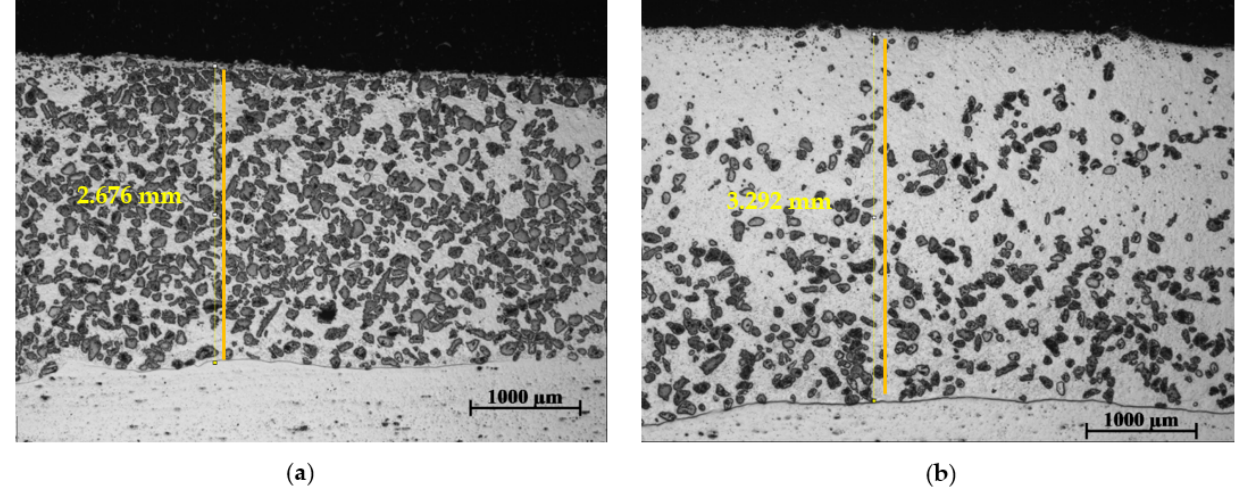
Figure 14. Cross-section of surface layers prepared with PG powder MMC at different PTA current values showing the measured thickness of surface layers ( a ) surface layer of 2-PG prepared at PTA current of 110 A ( b ) surface layer of 3-PG prepared at PTA current of 150 A.